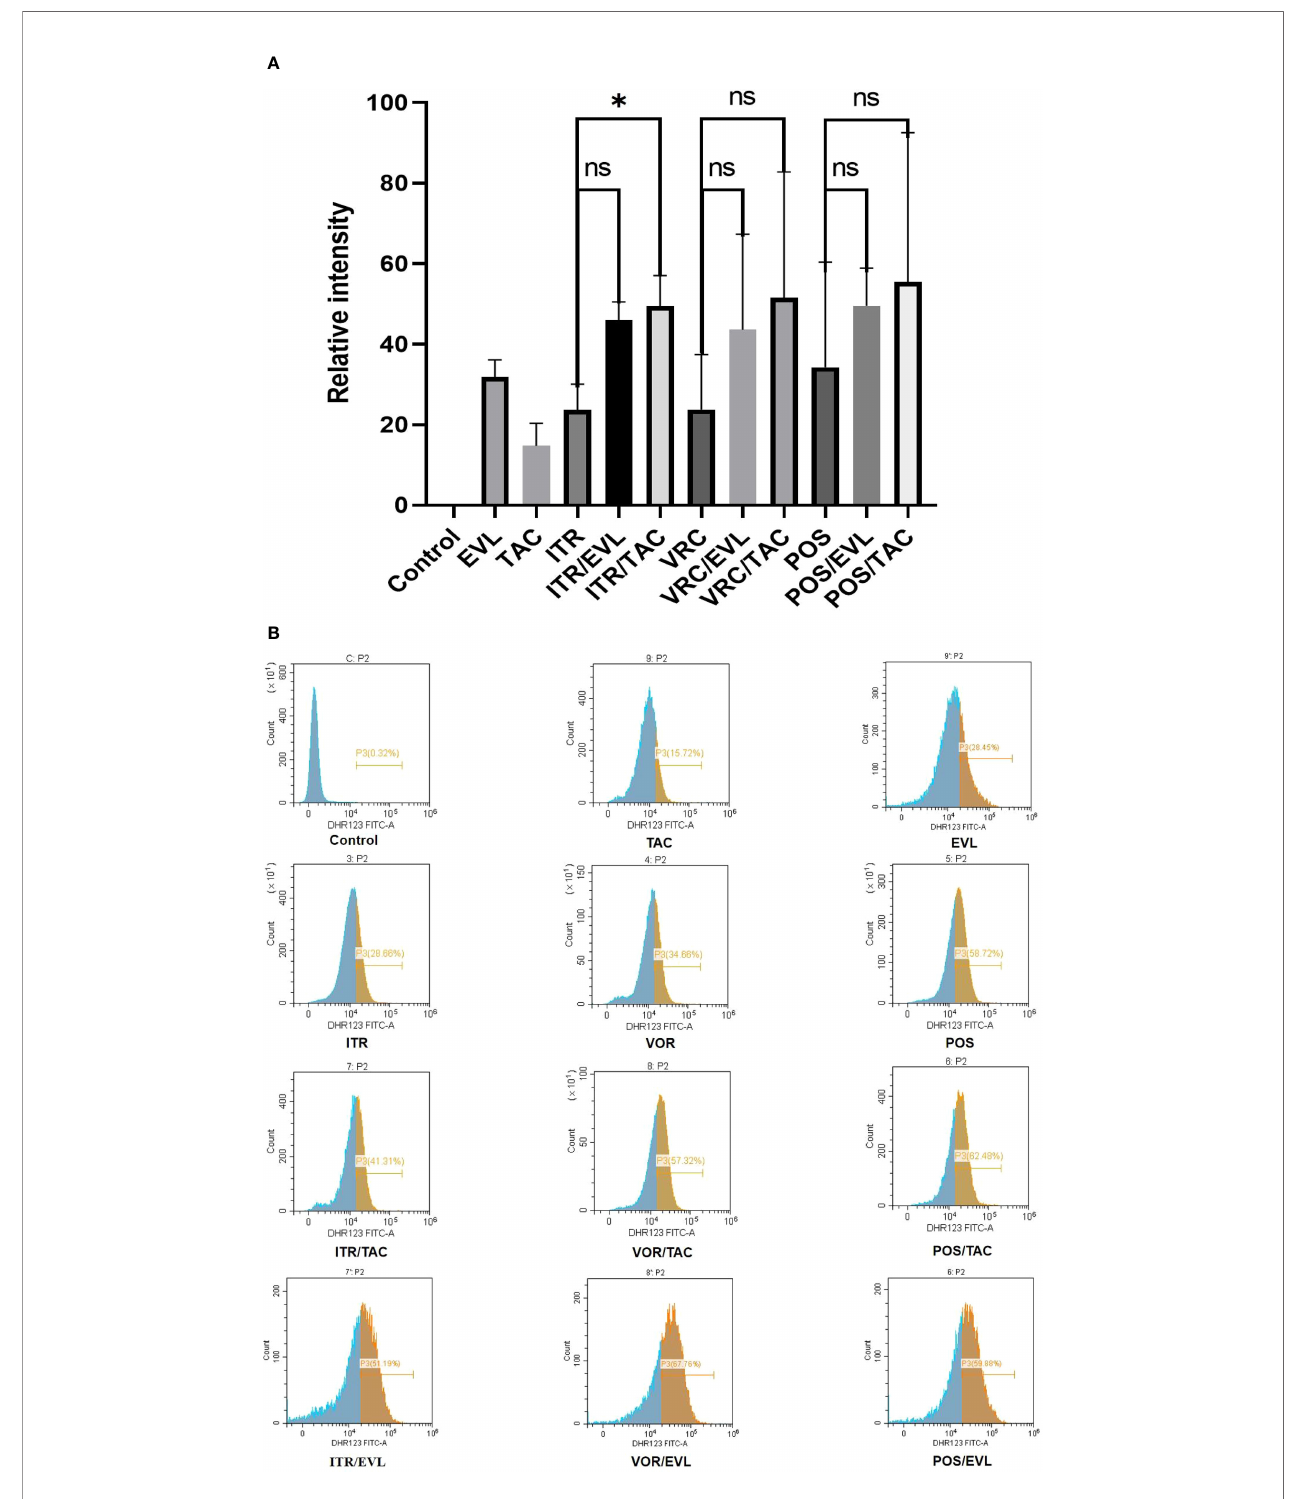
FIGURE 2 | Changes in ROS generation ratio across the single and combined drug groups. (A) The proportion of Dihydrorhodamine 123 oxidized by ROS in the control and experimental groups and related statistical analysis. (B) In fl ow cytometry analysis, the abscissa represents the relative fl uorescence intensity and the ordinate represents the spore count. The brown area represents the percentage of spores (P3) with emitted fl uorescence after Dihydrorhodamine 123 was oxidized to Rhodamine 123. The peak value in the brown area indicates the largest number of oxidized spores under the corresponding fl uorescence intensity. TAC, tacrolimus; EVL, everolimus; ITR, itraconazole; VRC, voriconazole; POS, posaconazole. *P < 0.05; ns, no signi fi